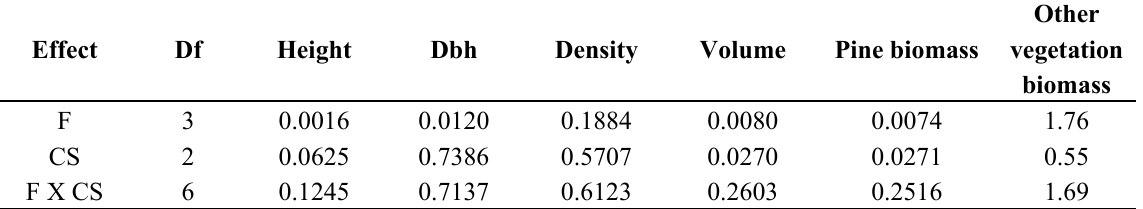
Table 2. Probabilities of a greater F -value for mean tree stand characteristics of 27-year-old loblolly pine stands subjected to four P fertilization rates (F), three direct-seeded interrow biomass energy cropping systems (CS), and their interaction (F X CS).